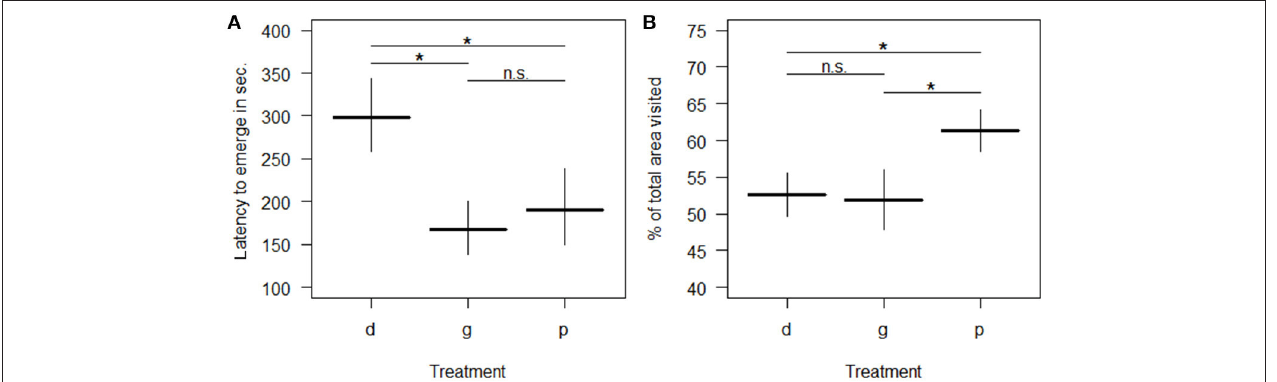
FIGURE 2 | Predicted mean levels ( ± SE) of behavioral responses in an open field test by spiders raised in one of three different treatment groups (d = “socially and physically deprived”; g = “socially enriched”; p = “physically enriched”). Panel (A) shows the latency to emerge; Panel (B) shows the percentage of area visited. All predictions derive from general estimated equations models (GEEs) after stepwise reduction to minimal adequate model including only significant terms. “n.s.” indicates non-significant ( p > 0.05 ) and “ * ” significant ( p ≤ 0.05 ) differences between the mean levels of